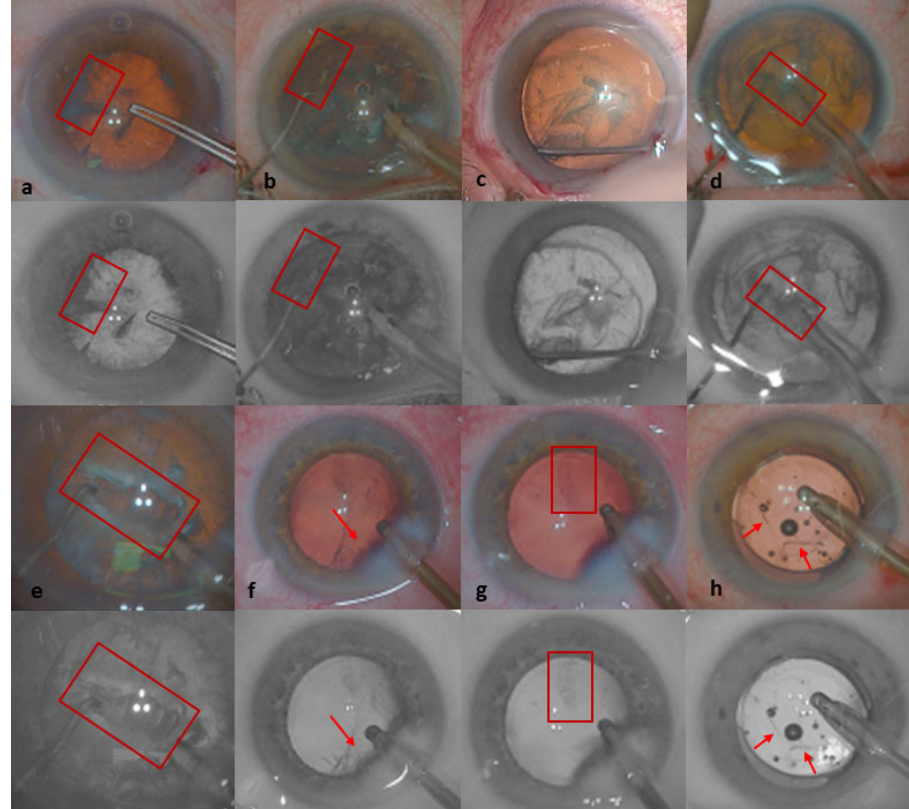
Figure 3. Natural color and BW filter images obtained at the same time points, at various stages in the surgery: Capsulorhexis visibility is enhanced with the BW filter over the anterior subcapsular lens opacities ( a ) and after hydrodissection before phaco-chop in conditions of poor red reflex illumination ( b ). ( c ) Hydrodissection fluid wave perception. ( d ) Enhanced contrast between instruments and the nucleus during phaco-chop. ( e ) The natural colors of the layers of the nucleus provide important information concerning the depth of the groove relative to the posterior capsule. ( f ) Subincisional cortex contrast through corneal edema is improved by the BW filter (arrow). ( g ) Residual cortical debris on the posterior capsule. ( h ) Viscous removal from the anterior chamber